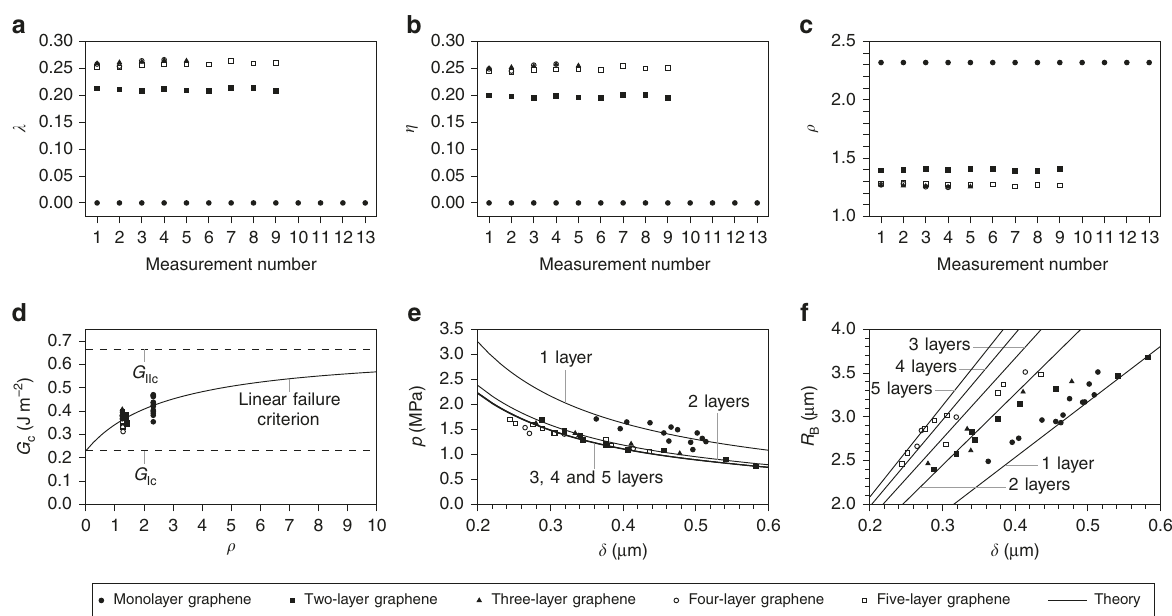
Fig. 2 Delaminating graphene fi lms under a pressure load. a – c Plots showing calculated values of the interlayer shearing and sliding parameter λ ( a ), the ratio η = G S / G J ( b ) and the fracture mode mixity ρ = G II / G I ( c ) based on the measured values of p and δ , and the material properties of monolayer graphene. d Plot showing adhesion toughness G c vs. the fracture mode mixity ρ . e , f Plots showing the measured and theoretical relationships between the pressure load p ( e ) and the blister radius R B ( f ) vs. the de fl ection at the centre of the blister